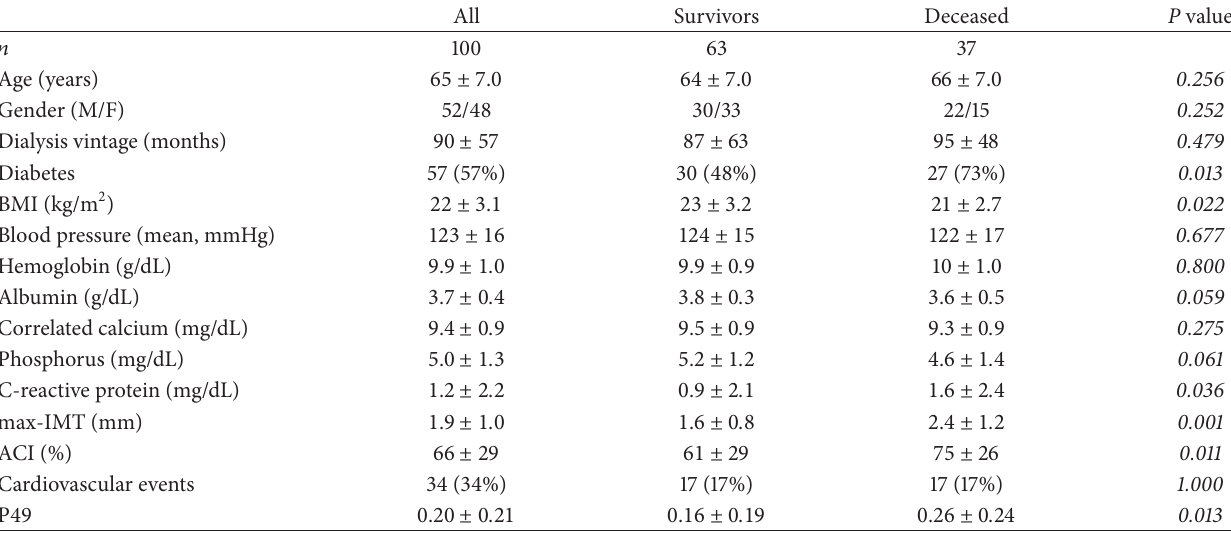
Table 2: Patient characteristics in the study